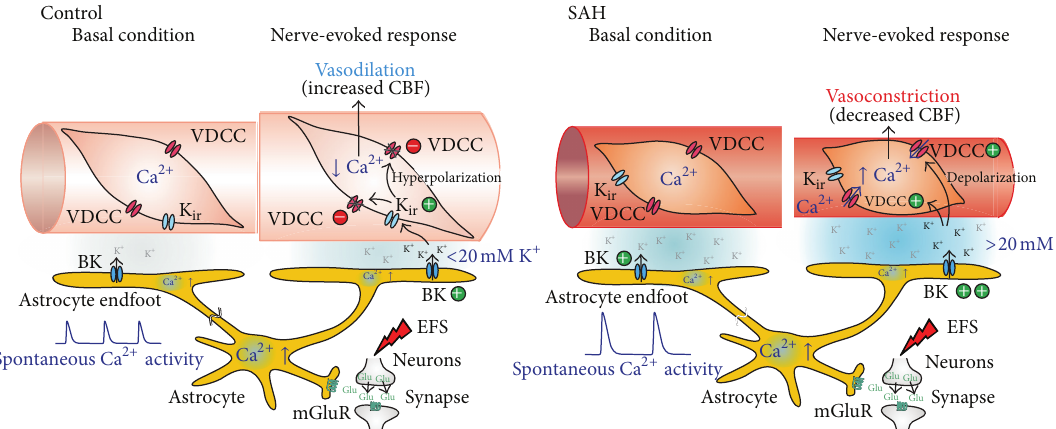
Figure 3: Schematic model liking SAH to inversion of neurovascular coupling. In control animals, EFS causes elevated cytoplasmic Ca 2+